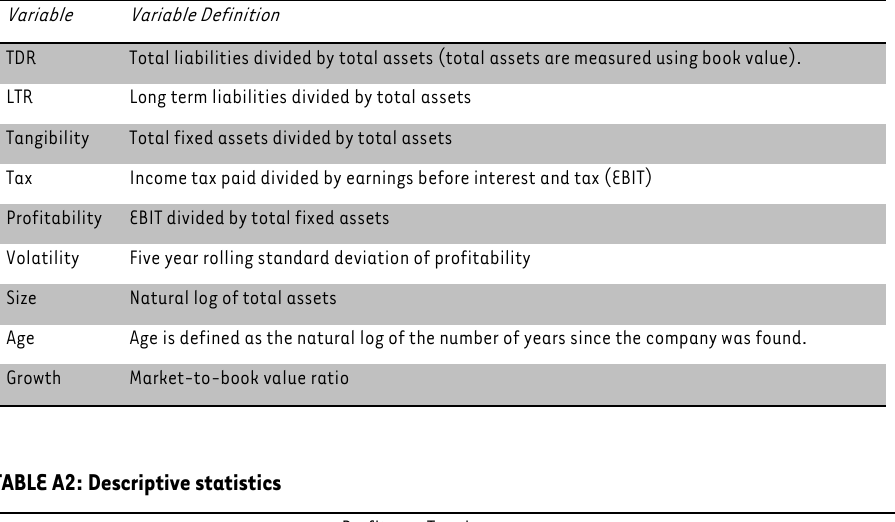
TABLE A1: Variables and their definitions